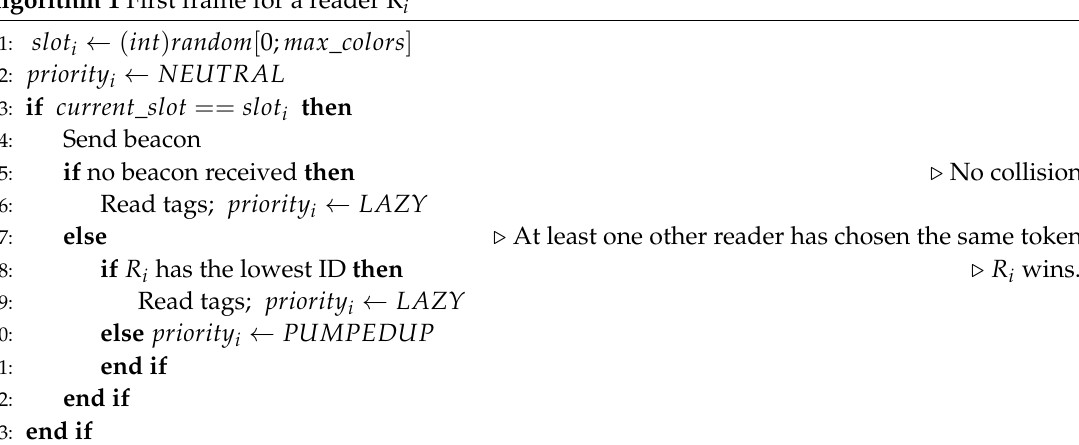
Algorithm 1 First frame for a reader R i